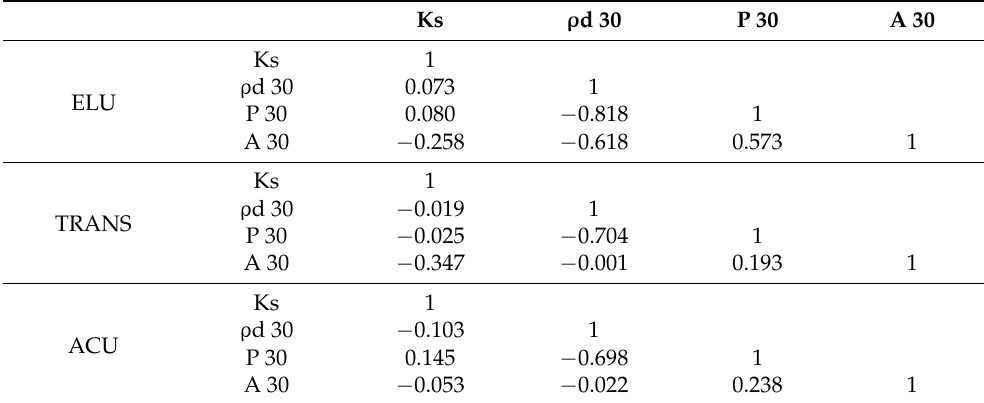
Table 3. Correlation analysis of all monitored parameters of hydro-physical properties at 30 cm of the soil